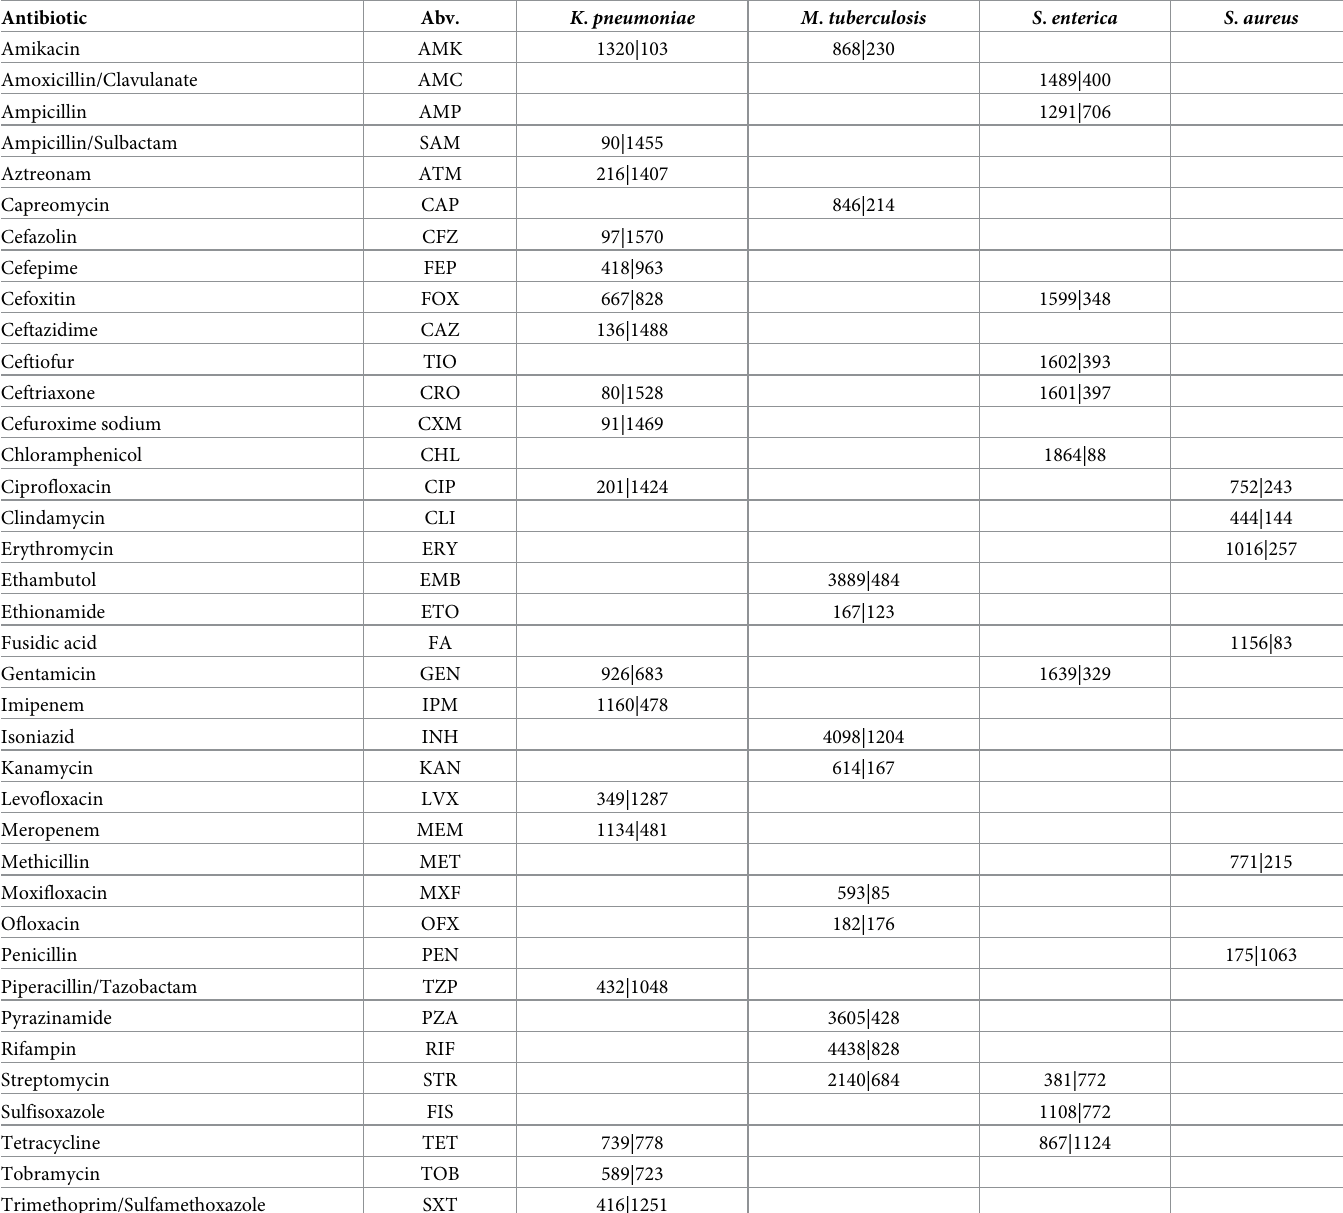
Table 2. Counts of susceptible and resistant genomes used in this study, data are displayed as (Susceptible|Resistant). Antibiotic